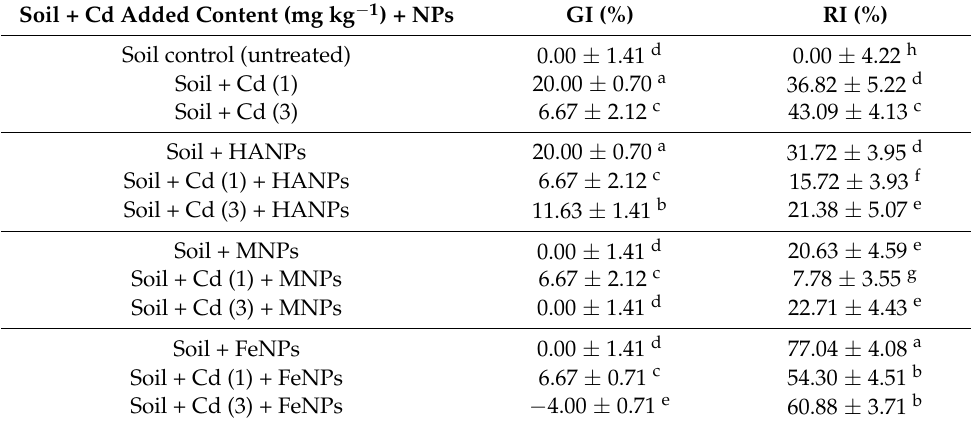
Table 4. Germination inhibition (GI) and root growth inhibition (RI)